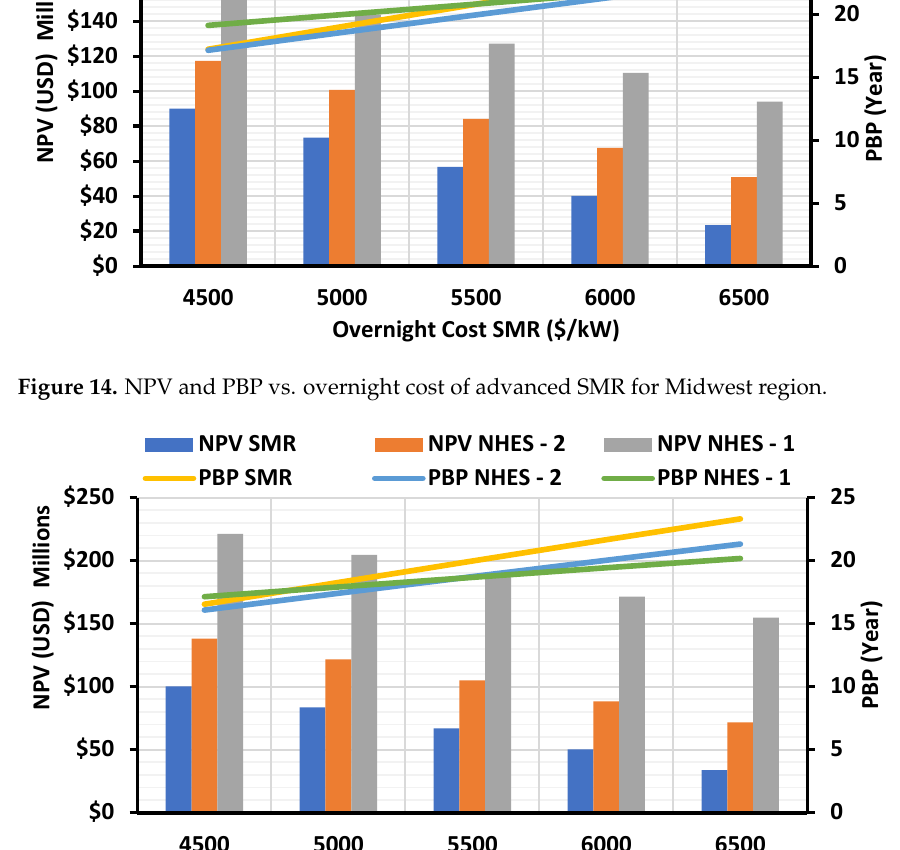
Figure 16. NPV and PBP vs. overnight cost of advanced SMR for Southwest region .